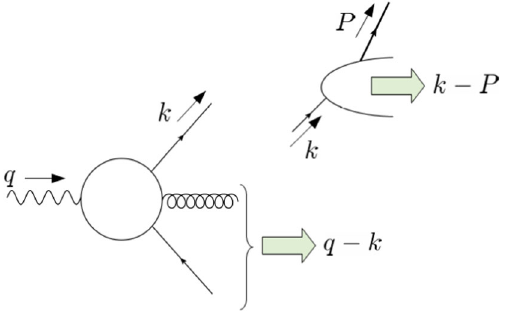
Fig. 14 Momentum flow that determines the kinematics boundaries on (cid:6) z